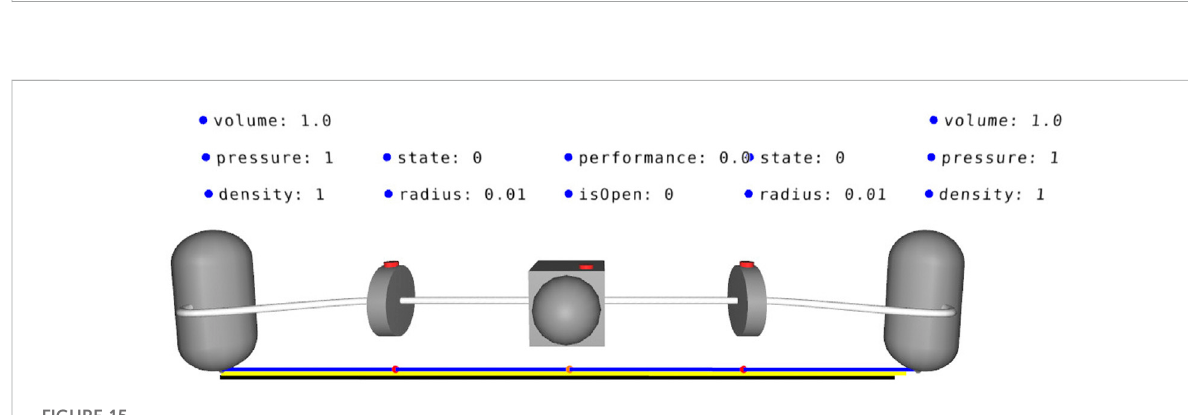
FIGURE 14 CausalVR concept, using CausalAI with simulations of interactive virtual models of machines and production lines.